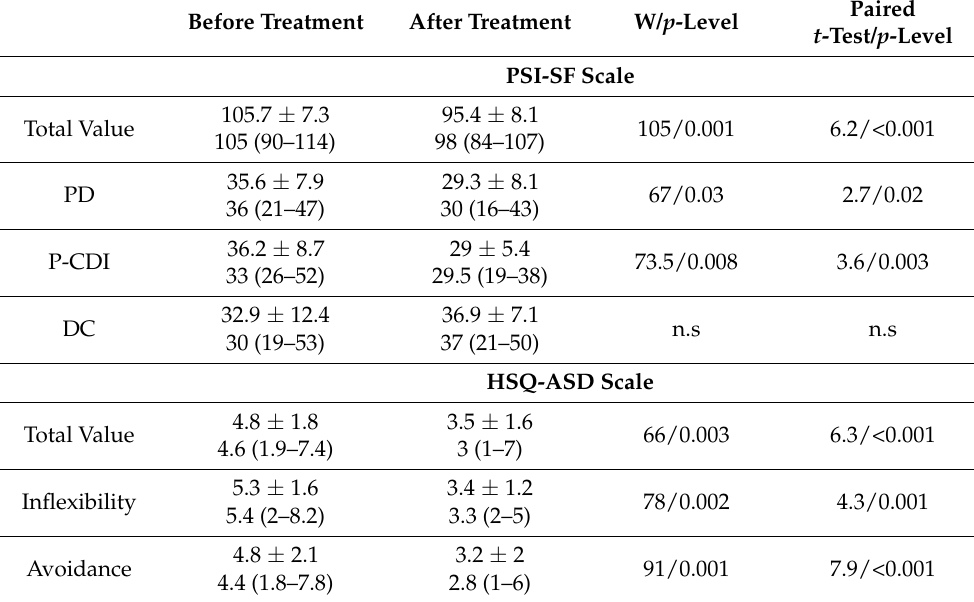
Table 7. Psychological effects on parents before and after BST